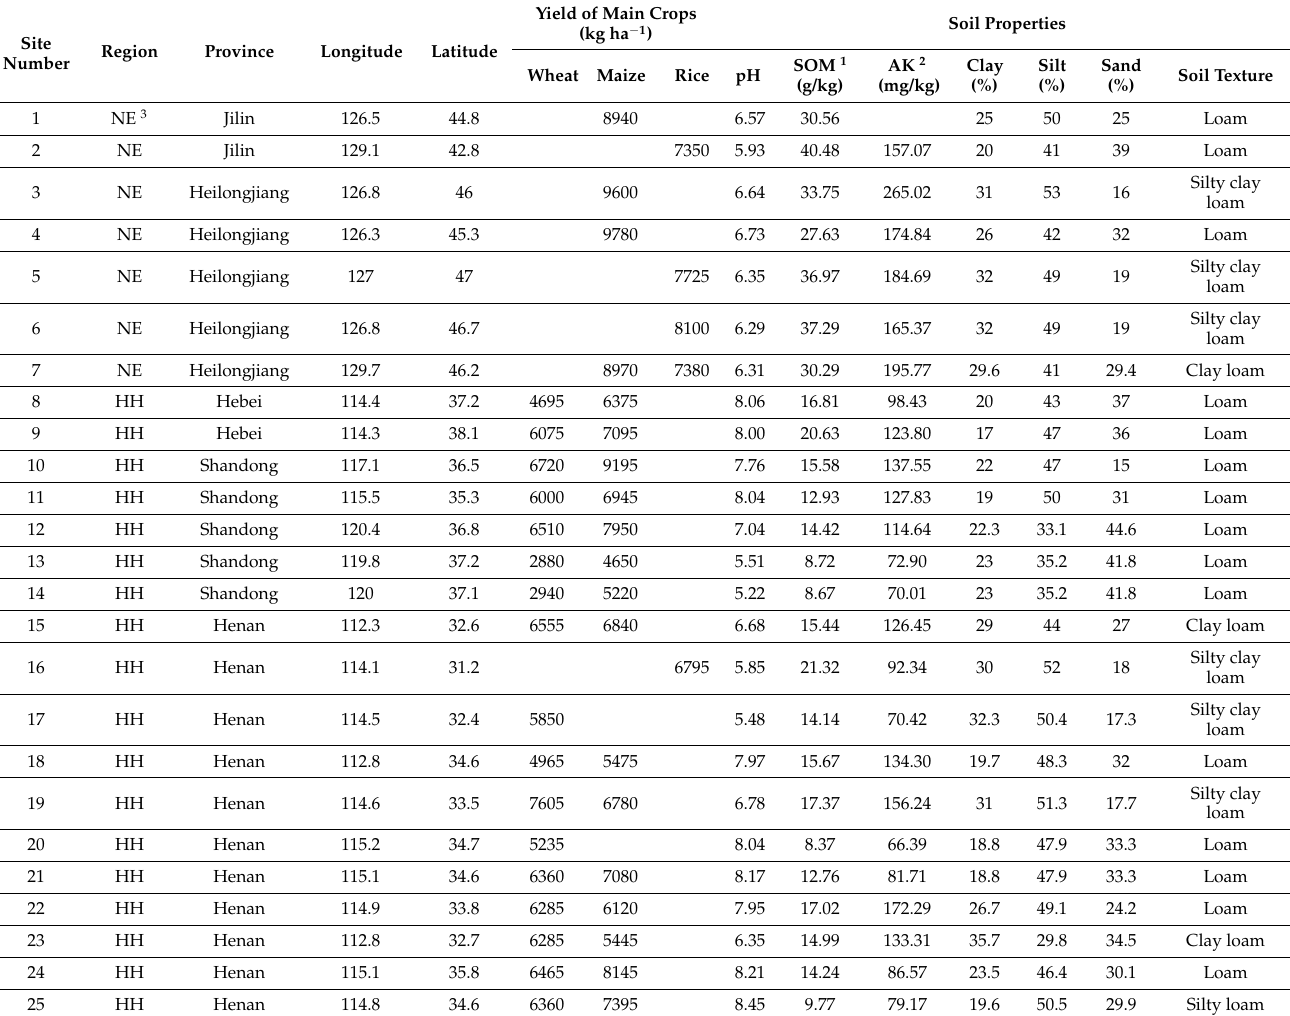
Table A1. Detailed information of field experimental